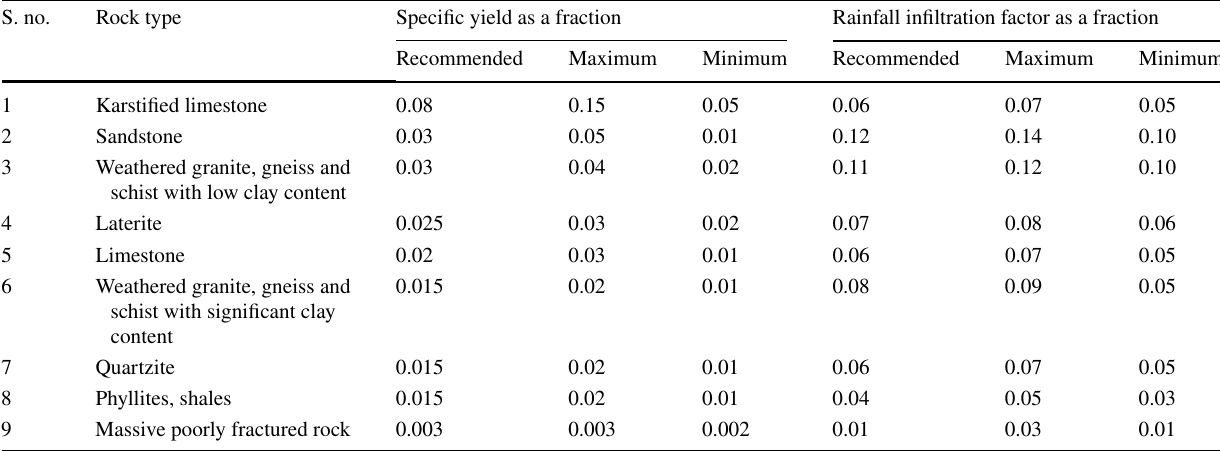
Table 1 Norms for specific yield (GEC 1997) S.